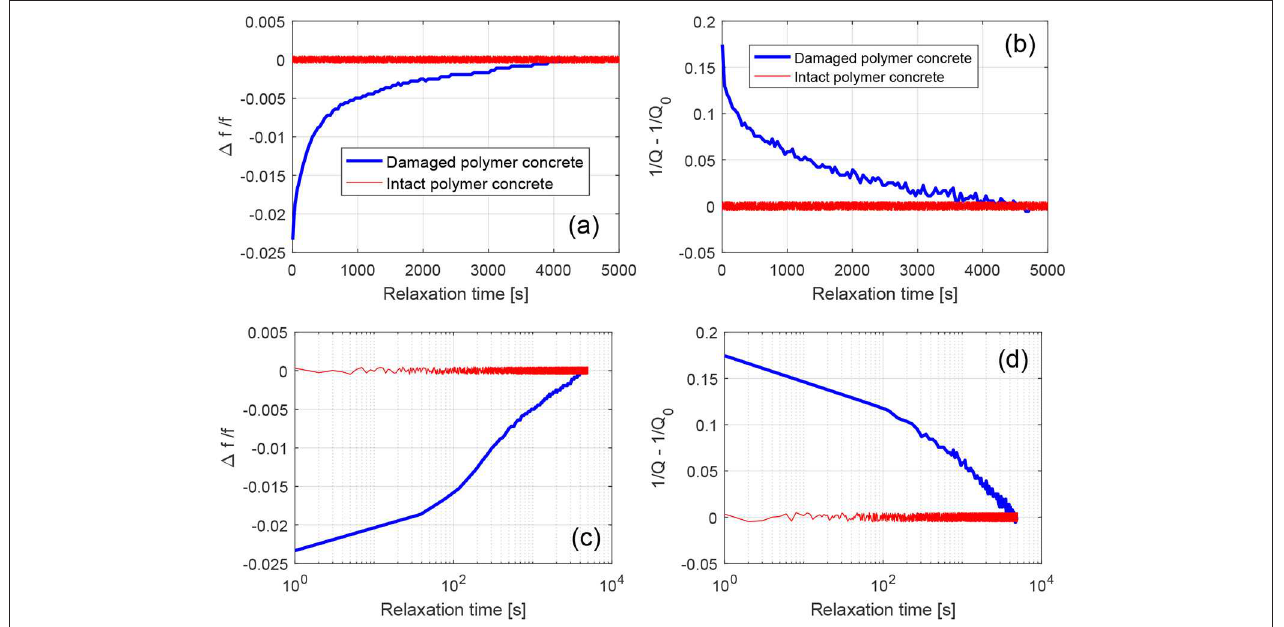
FIGURE 7 | (a–d) Variation of resonance frequency and Q-factor vs. time for damaged and intact polymer concrete samples. The same data are shown in the lower row in semilog